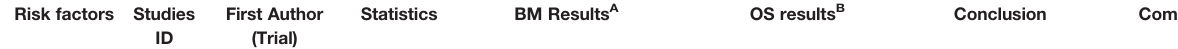
TABLE 1 | Risk factors for BM in